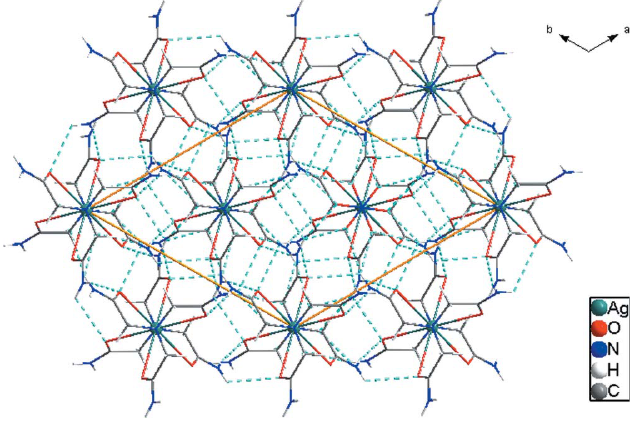
Figure 2 The packing diagram for the title compound, viewed along the c axis, with hydrogen bonds drawn as dashed lines.